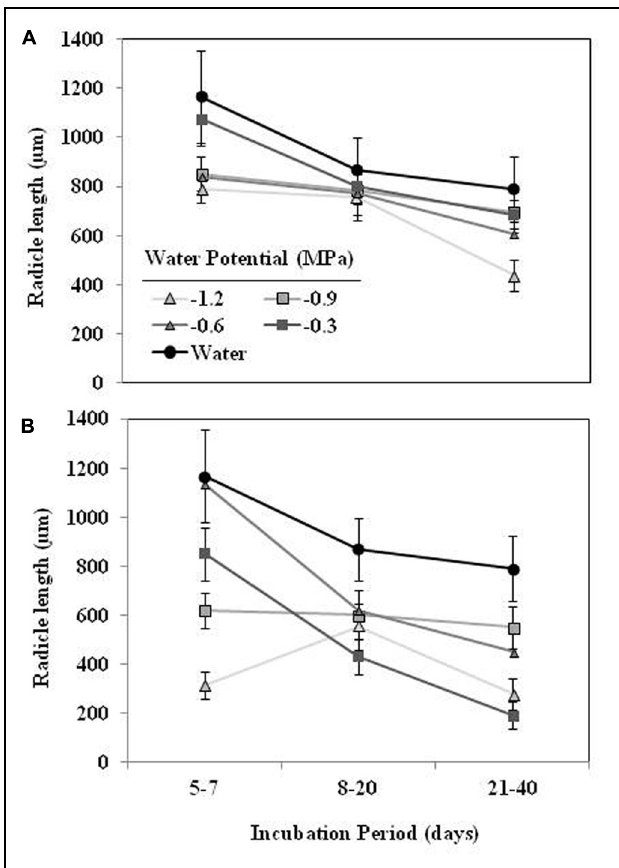
FIGURE 4 | Effect of the incubation period, during which the O. crenata seeds germinated (days after GR24 addition), on the radicle length seeds ( μ m) under matric (A) or osmotic potentials (B). Points represent the average of six repetitions. Bars represent the SE of each